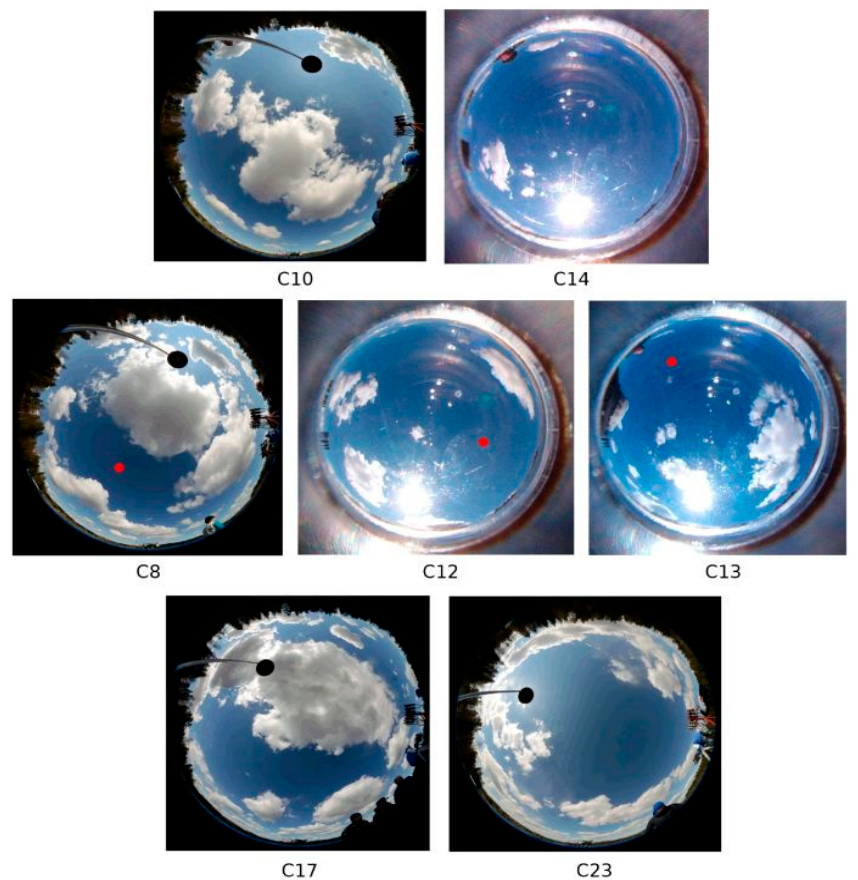
Figure 5. All-sky camera images captured in the middle of the casts used in the intercomparison analysis. Irradiance—C10, C12, C13, C14; blue sky radiance—C8, C12, C13; water radiance—C17, C23. Red dots in C8, C12, C13 indicate approximate view direction of the radiance sensors.